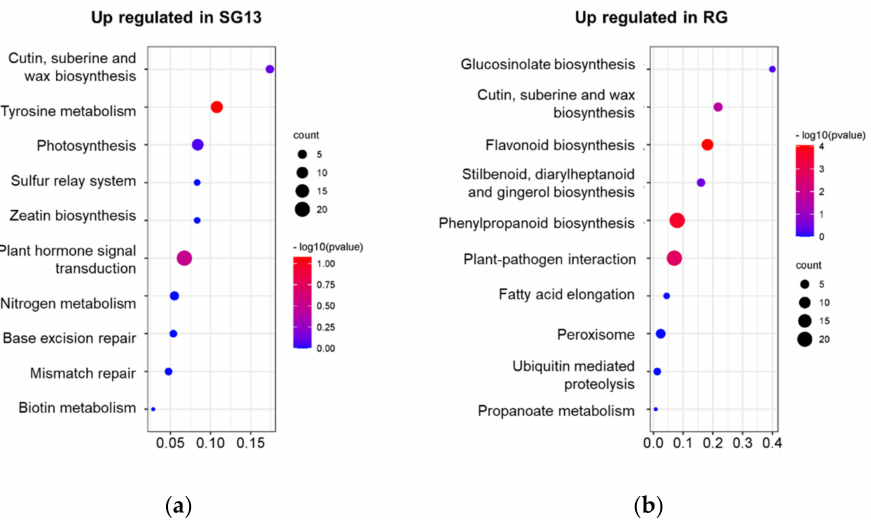
Figure 2. Statistics of KEGG pathway enrichment. The 10 most significant catalogues with lowest corrected p -value based on DEGs expressed more in ( a ) RG and ( b ) SG13,